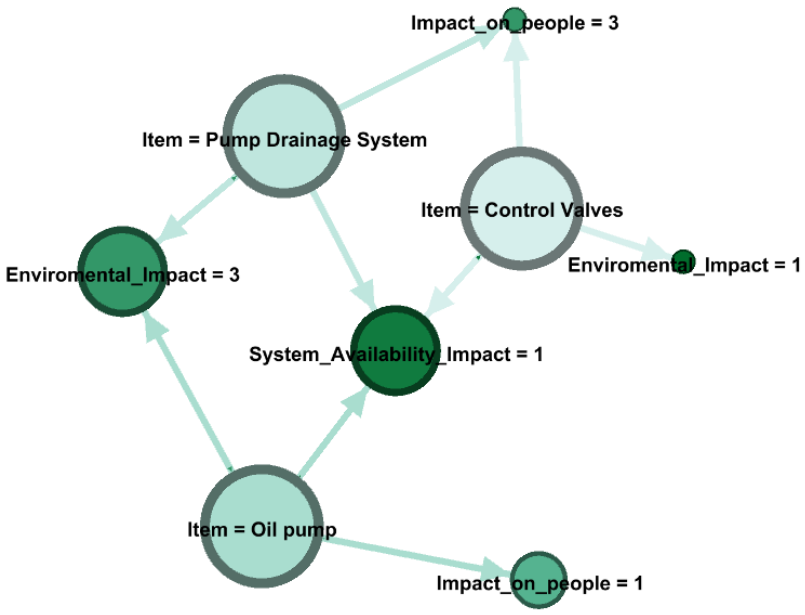
Figure 3. Relationships among items, potential failure modes, impact on safety, environment and system availability. system